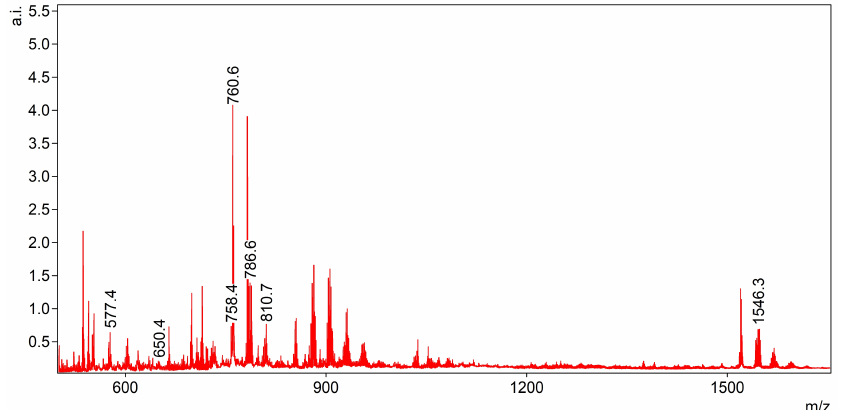
Figure 2. Peaks chosen for the analysis in the positive ionization mode (marked by their m / z ratios).